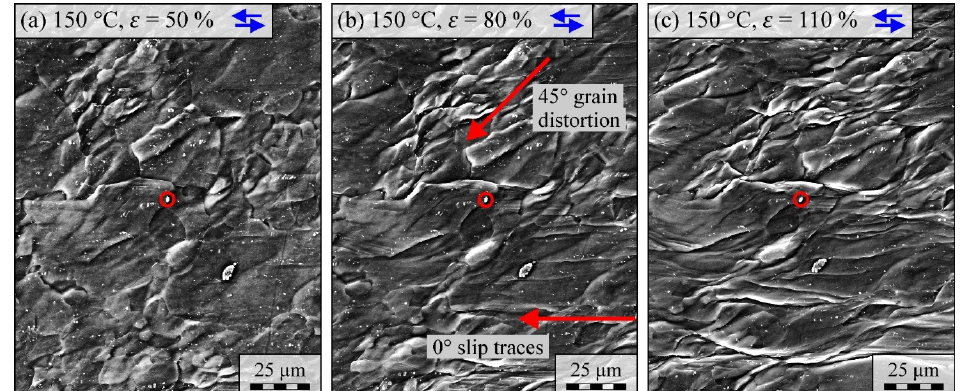
Figure 5. Example of a 150 °C simple shear specimen (loading direction indicated by blue arrows) with a tracked particle indicated by red circles and the orientation of slip traces indicated by red arrows; elongation 𝜀 indicated with reference to the initial gauge length of 1 mm being ( a ) 50%, ( b ) 80% and ( c ) 110%.